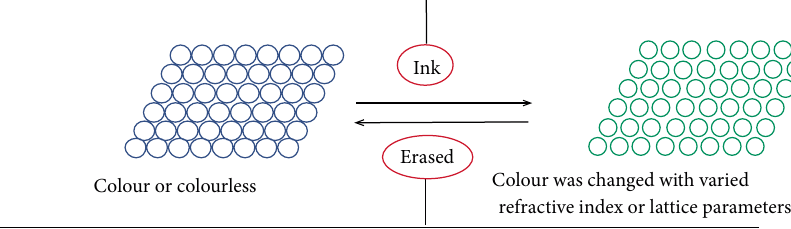
Figure 3: Photonic paper patterned by ink